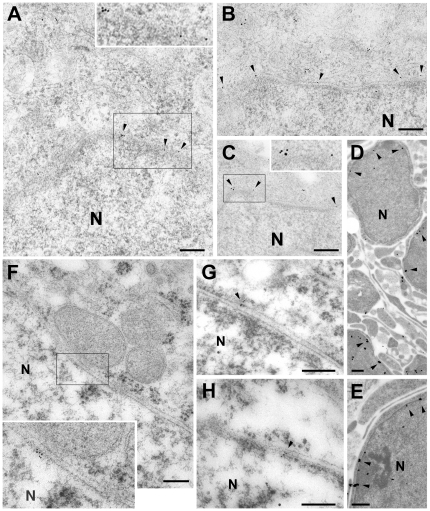
Electron micrographs show postembedding immunogold labeling for KV10.1 in MCF-7 cells (A–C), postnatal day 7 cerebellum (D–E) and adult pyramidal cells in CA1 (F–H).Gold particles are observed in the perinuclear inner membrane and/or adjacent to the ONM. N = Nucleus, Scale bars: 0.1 µm.